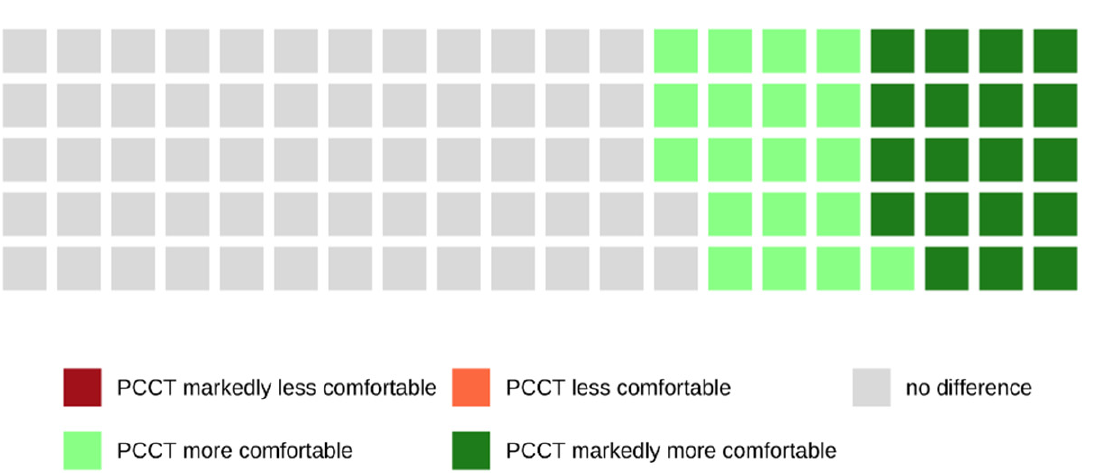
Figure 7. Horizontal stacked bar chart showing the perceived time to hold the breath. Patients had significantly less difficulty holding their breath when examined with the PCCT compared to the SCT (PCCT 4.9 ± 0.5 versus SCT 4.36 ± 1.2, p < 0.001). Of all patients who were examined with the PCCT and who were able to make a comparison between both scanners because of their previous CT examinations with the SCT, 38.6% rated the examination with the PCCT as more or markedly more comfortable, whereas 61.4% did not notice a difference between both scanners (see also Figure 8).